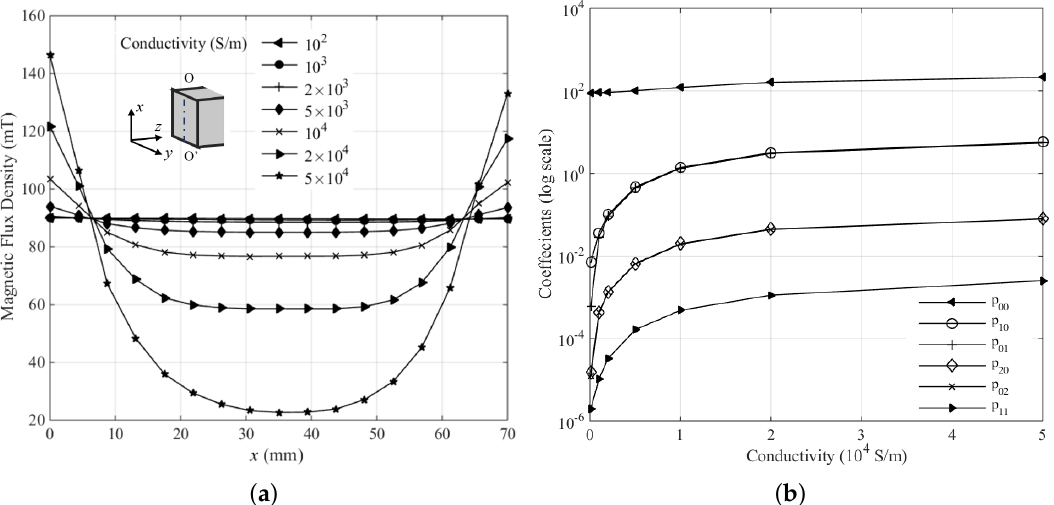
Figure 9. ( a ) The magnetic flux density distribution on median line O-O’ under different conductivity from 10 2 S/m to 5 × 10 4 S/m based on the FEM; ( b ) The variation of coefficients (log scale) in the empirical formula along with the